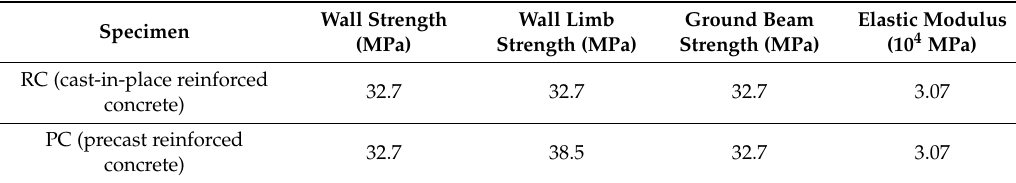
Table 2. Material properties of rebars and steel plate.